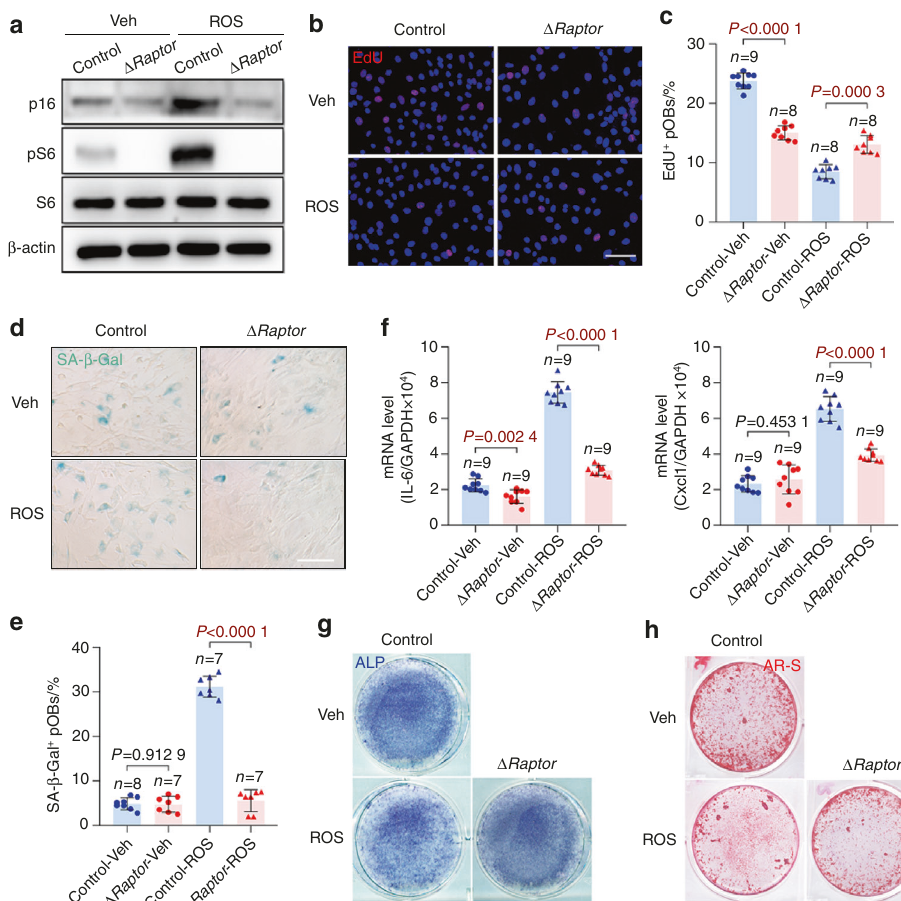
Fig. 4 mTORC1 inhibition enables preosteoblast escape from senescence in vitro. a Primary calvarial osteoblasts isolated from neonatal Δ Raptor and Raptor fl / fl mice were induced to undergo senescence by ROS. After 3 days, the cells were analyzed for senescence marker (p16 and p53) expression and mTORC1 activity (pS6) with western blotting. b Immunostaining of EdU in the senescence-induced cells in a . Scale bar, 50 μ m. c Quantitative analysis of EdU + cells relative to total cells. d Representative images of SA- β -gal staining of the senescence-induced cells in a . Scale bar, 100 μ m. e Quanti fi cation of the proportion of SA- β -gal-positive cells in each population. f qPCR analysis of IL-6 and Cxcl1 mRNA in the primary preosteoblasts in a . The cells in a were then induced to undergo osteogenic differentiation and subjected to ( g ) ALP staining or ( h ) AR-S staining on Day 7 or 14, respectively, after induction of differentiation. Data are shown as the mean ± SD. The numbers of samples ( n ) are indicated in each fi gure panel. P values were determined with two-tailed Student ’ s t test for single comparisons injected the aged Δ Tsc1 mice with adenovirus encoding si-Scn1a. With interference with Scn1a expression in preosteoblasts (Fig. 6i), the Δ Tsc1 mice exhibited alleviated preosteoblast senescence (Fig. 6j) and increased bone mass (Fig. 6k, l). Histomorphometric measure- ments further showed increased mineral apposition rates (MARs) indicative of higher bone formation activity of osteoblasts in the Δ Tsc1 mice receiving si-Scn1a (Fig. 6m). These results demonstrated that Scn1a functionally mediated plasma membrane potential changes and cellular senescence in preosteoblasts. Prosenescence stress activates Scn1a by inhibiting its phosphorylation by PKA Interestingly, we further found that the regulation of membrane depolarization by mTORC1 was con fi ned to senescent osteoblasts, because mTORC1 activation or inhibition did not cause a signi fi cant change in membrane potential in replicative osteoblasts without senescence induction (Fig. 7a). This result suggested that the permeability of Scn1a to Na + might be controlled by prosenescence stress. The function of Scn1a in mediating sodium currents is suppressed by its phosphorylation by the protein kinase PKA. 26 – 28 Coincidentally, PKA activity has been reported to be diminished in senescent cells. 29 Therefore, we reasoned that prosenescent stress